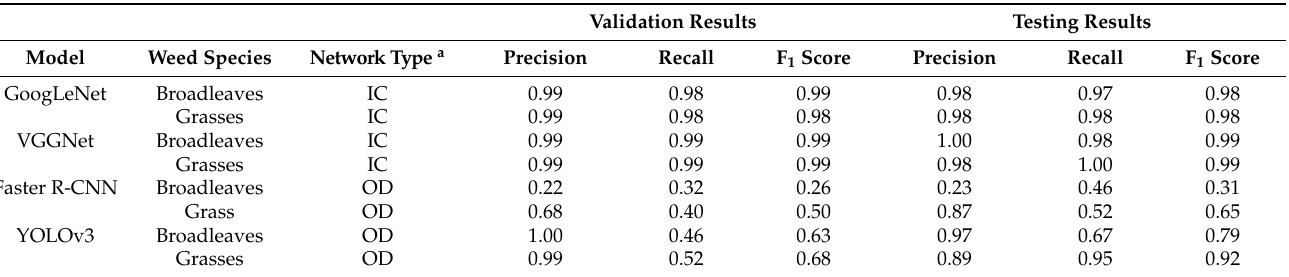
Table 3. The validation and testing results using image classification and object detection neural networks for the detection of weeds growing in alfalfa b